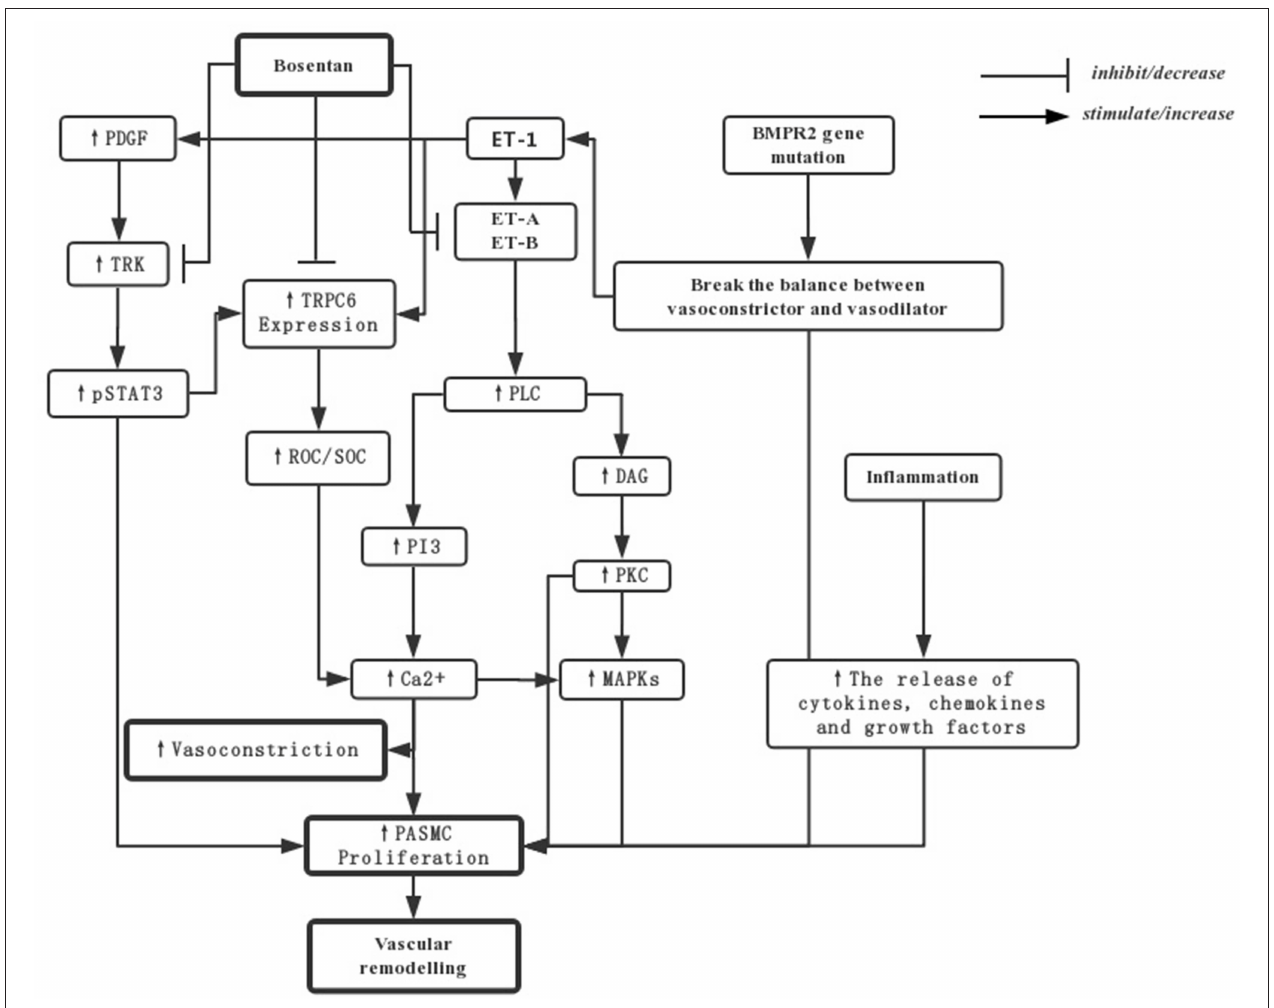
FIGURE 1 | The mechanisms for bosentan in treating PAH. PDGF-mediated activation of TRKs can upregulation of TRPC6 expression by activating of STAT3 phosphorylation. The resultant increase in the activity of pSTAT3 and ROCs and SOCs would increase Ca 2 + to stimulate PASMCs and vasoconstriction. The over-expression of ET-1 can increase levels of PVR by ET-A and ET-B activation through PLC and the downstream in PI3 and DAG pathways. What’s more, the balance between vasoconstrictive and vasodilatory mechanisms may be broken by the mutations in BMPR2, and the release of inflammation factors may also induce proliferation of cells. Bosentan, as an endothelin receptor antagonist, directly downregulates TRPC6 and TRK expression by repressing the gene transcription or translation, in addition to blockade of endothelin receptors and their downstream signal transduction pathway traditionally. PASMCs, pulmonary artery smooth muscle cells; DAG, diacylglycerol; PKC, protein kinase C; ROCs, Receptor-operated Ca 2 + channels; SOCs, store-operated Ca 2 + channels; TKRs, PDGF-mediated activation of tyrosine kinase receptors; pSTAT3, transcription-3 phosphorylation; PDGF, platelet-derived growth factor; TRPC, transient receptor potential